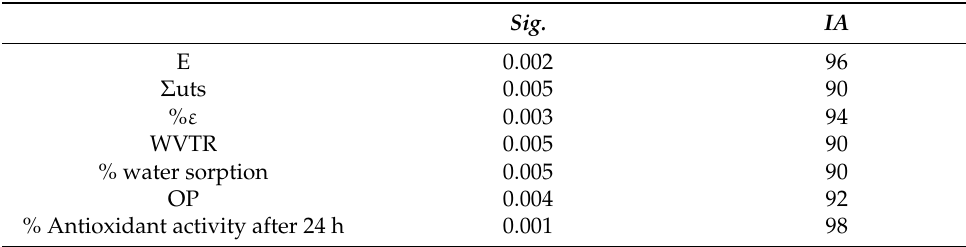
Table 4. Mean values inequality test of modulus of elasticity (E), tensile strength ( σ uts), % elongation at break ( ε b), water vapor permeability WVTR, % water sorption, oxygen permeability (OP), and % antioxidant activity after 24 h of all tested